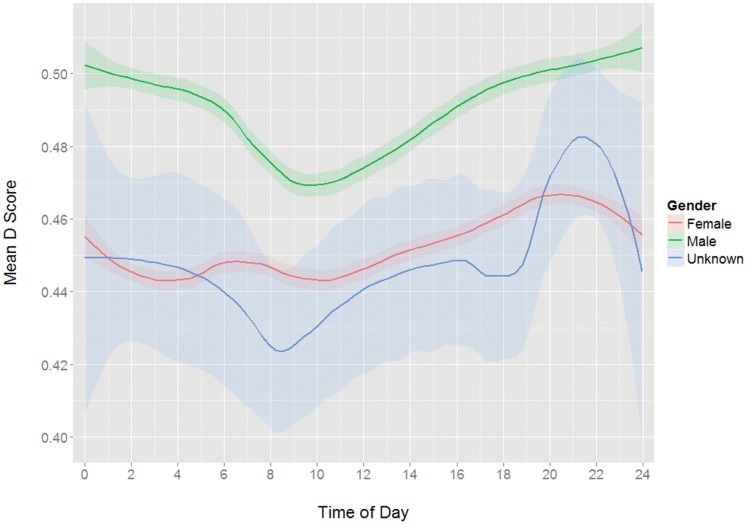
Mean D scores by time of day grouped by gender.